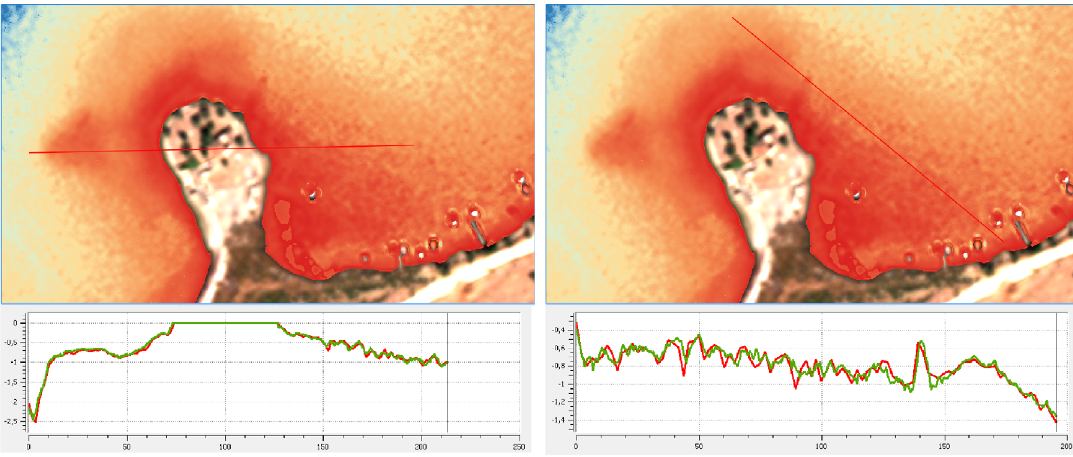
Figure 14: Two examples of bathymetry profiles at the Metohi peninsula on the 19.09.2013. Red line represents bathymetry derived with WorldView-2 data with a resolution of 1.6 m, while green line represents bathymetry derived with pan-sharpened data with a resolution of 0.4